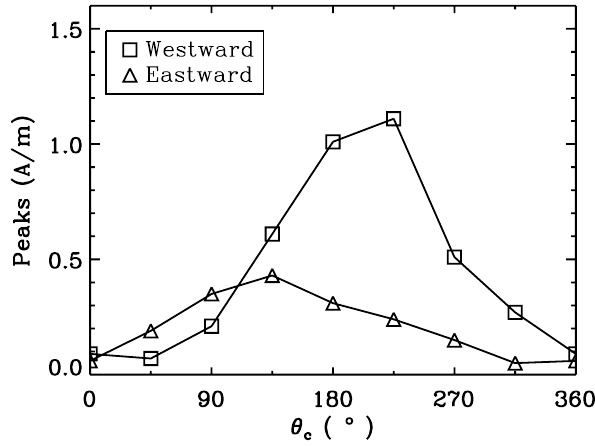
Fig. 2. Peak values of the westward currents and eastward currents as a function of the IMF clock angle θ c . Square and triangle symbols represent westward and eastward peak values,